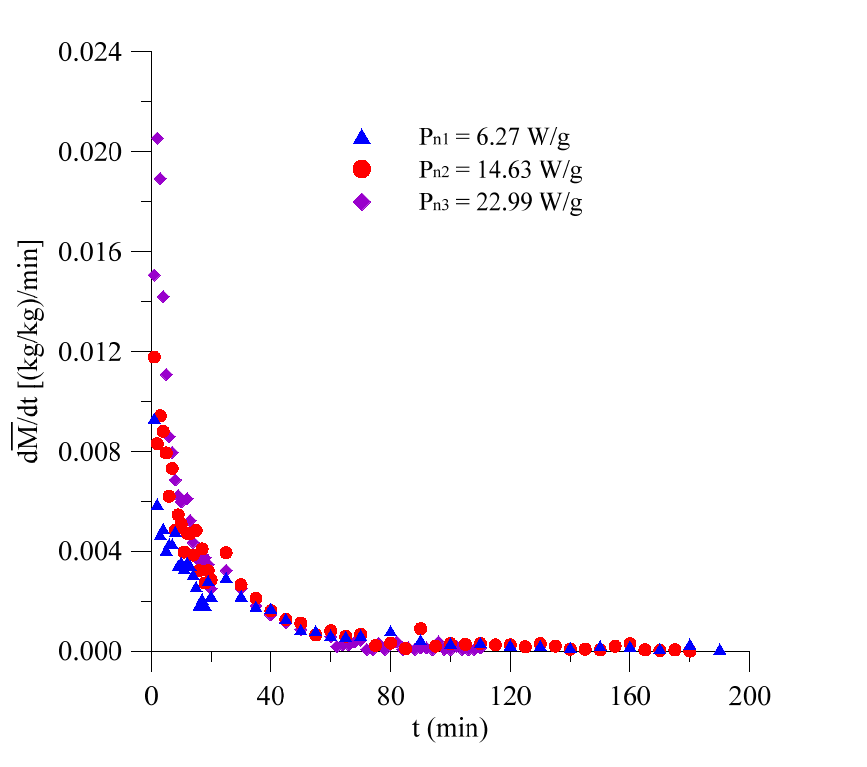
Table 4. Moisture content of the rice grains at the different moments of drying.